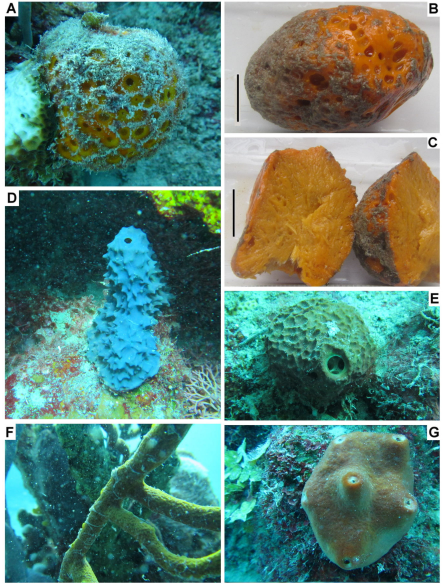
Figure 1. Sponge specimens harboring nematode populations: ( A ) Cinachryrella sp. (specimen PA13 in situ); ( B ) Cinachryrella sp. (specimen PA21 delivered on board); ( C ) Cinachryrella sp. (specimen PA21 cut); ( D ) Aiolochroia crassa (specimen PA2 in situ); ( E ) Verongula rigida (specimen PA20 in situ); ( F ) Aplysina fulva (PA22 in situ); ( G ) Unidentified demospongian (specimen PA8 in situ). ( B , C )—scale 3